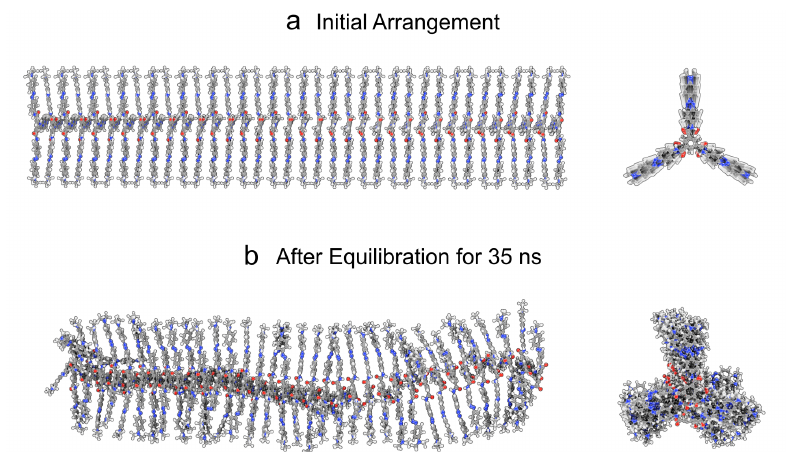
Figure 2. Columnar stack containing N = 36 TrisAzo molecules shown from the side and top. ( a ) Initial arrangement of the stack before starting the simulations, and ( b ) after 35ns of equilibration time under normal conditions. The visualizations are generated using a combination of the 3D graphics software Blender [49], the plugin BlendMol [50], and the MD visualization tool VMD